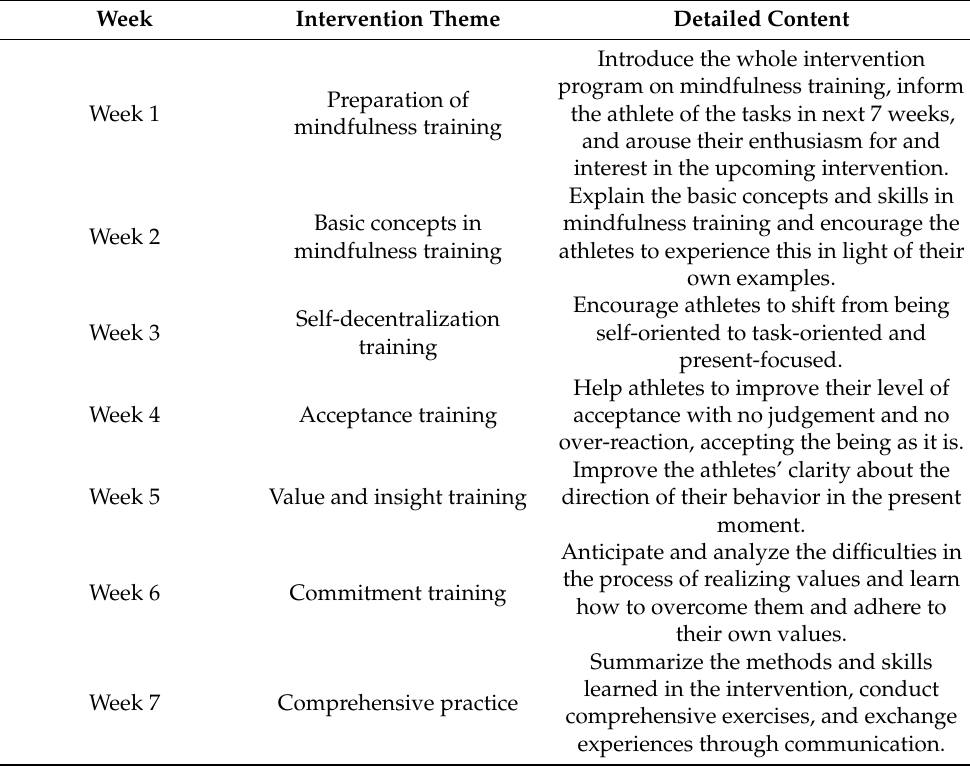
Table 1. Content of MAIC